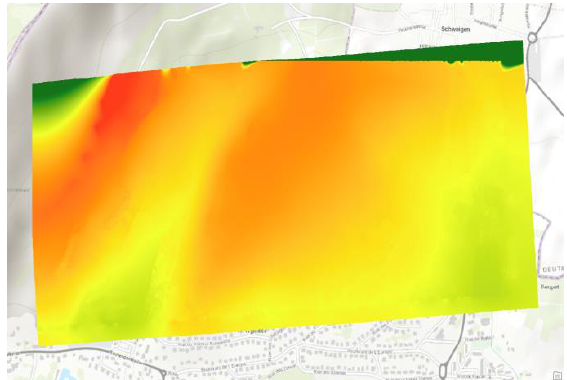
Figure 14. The final result of the soil erosion risk that mainly is related to the terrain